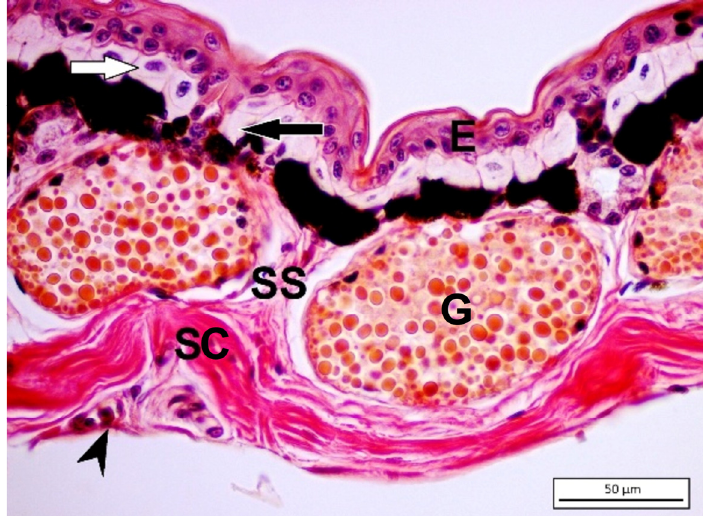
Figure 3. Picro-ponceau staining method on Hyla savignyi dorsal skin. (E) Epidermis; (G) granular glands; (SS) stratum spongiosum; (SC) stratum compactum; hypodermis (arrowhead). Rows of chromophores are visible just below the basement membrane. White arrow indicates xanthophore while black arrow indicates iridophores, which are upon melanophores.